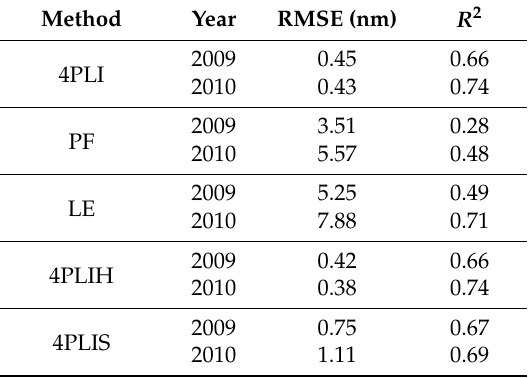
Table 1. Comparison of RMSE and R 2 values of REP SIM and REP IMG (Calculated by 4PLI, PF, LE, 4PLIH and 4PLIS methods).